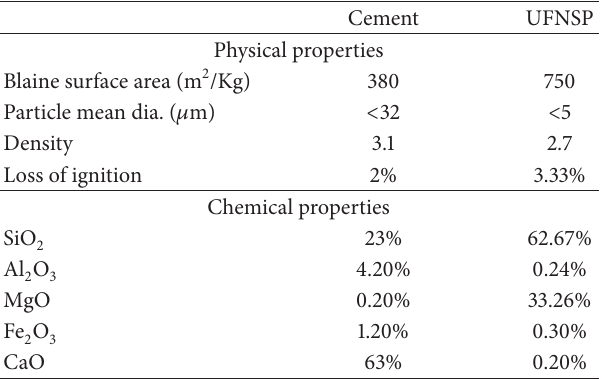
Table 1: Physical and chemical properties of cement and UFNSP.